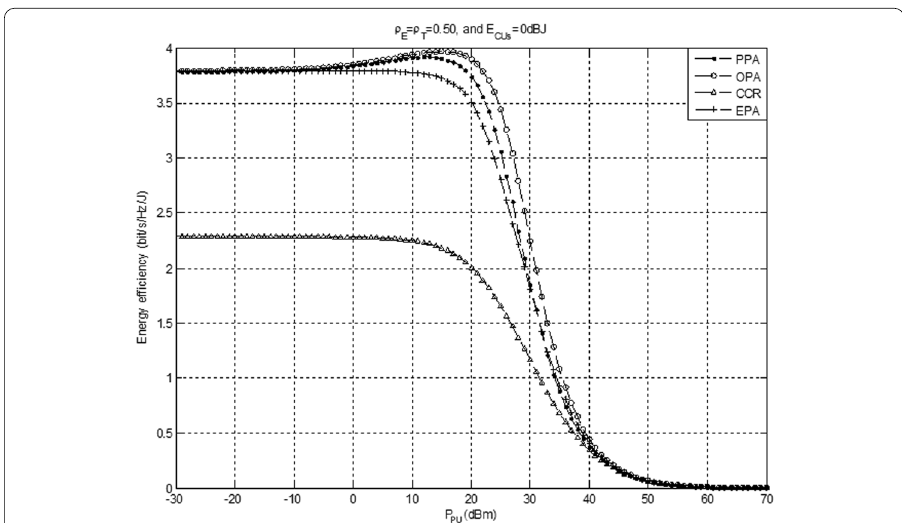
Fig. 6 Energy efficiency for different algorithms as a function of P